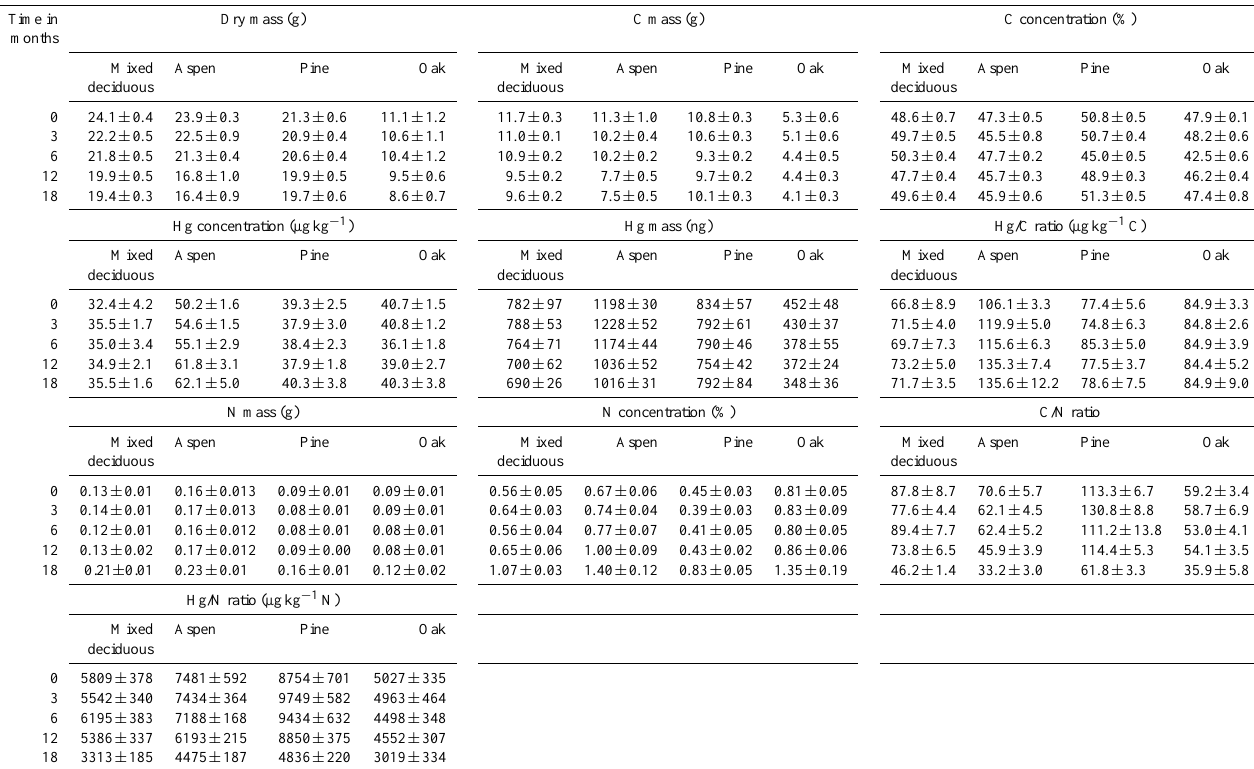
Table 1. Dry mass, C mass, C concentration, Hg concentration, Hg mass, Hg/C ratio, N mass, N concentration, C/N ratio, and Hg/N ratio of laboratory